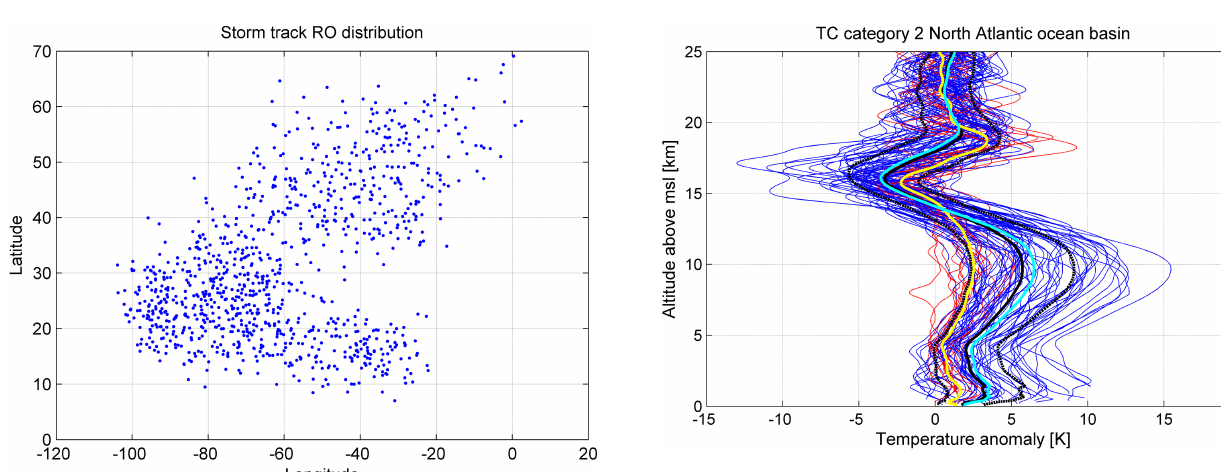
Figure 5. RO temperature anomaly profiles during TC category 2 in the North Atlantic Ocean basin. In red the tropical profiles, in blue the extratropical profiles, in yellow the mean anomaly of tropical profiles, in light-blue the mean anomaly of extratropical profiles, in black the mean of all the profiles and dashed black the mean plus/minus the standard